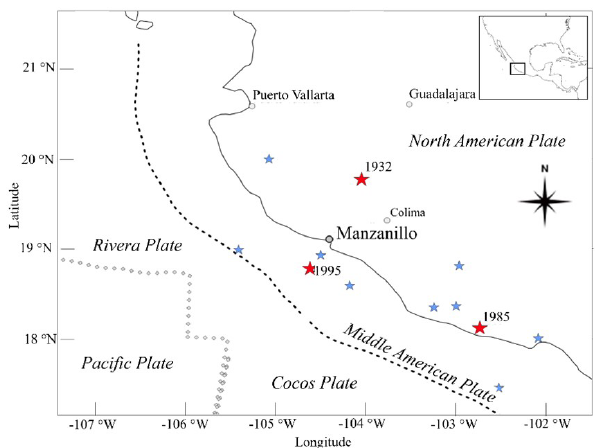
Figure 2. Seismic environment of the study area. Red stars indicate earthquakes M ≥ 8 . 0; blue stars indicate earthquakes 7 . 0 ≤ M ≤ 8 .